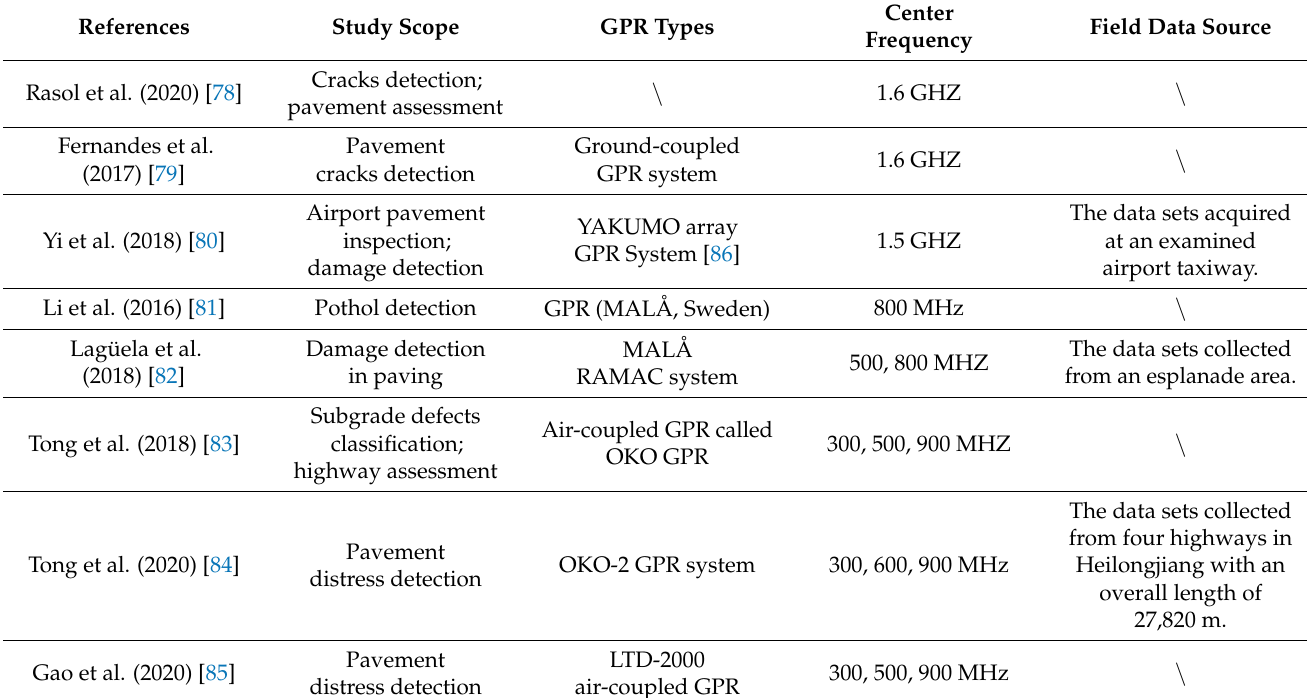
Table 2. Some examples for road distress detection based on